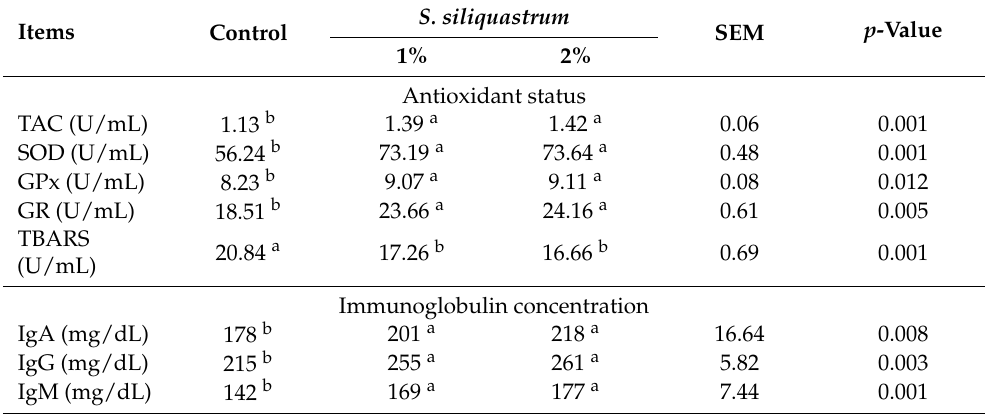
Table 8. Effect of S. siliquastrum dietary treatment on blood antioxidant status and immunoglobulin concentration in Japanese